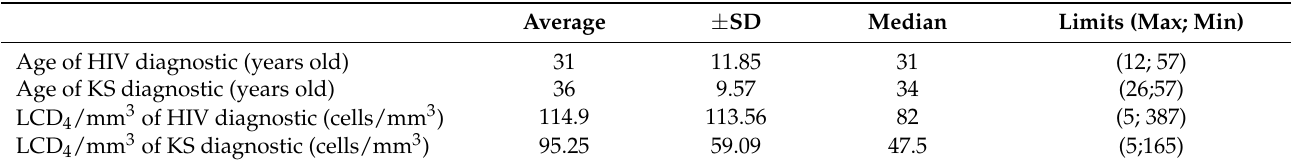
Table 3. Statistic characteristics of numeric variables for 10 patients with HIV and Kaposi